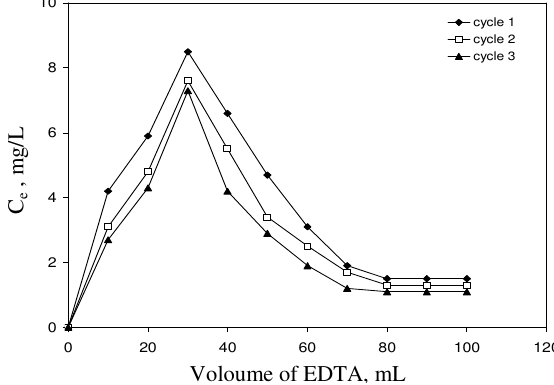
Figure 4. Desorption curves of fluoride adsorbed on